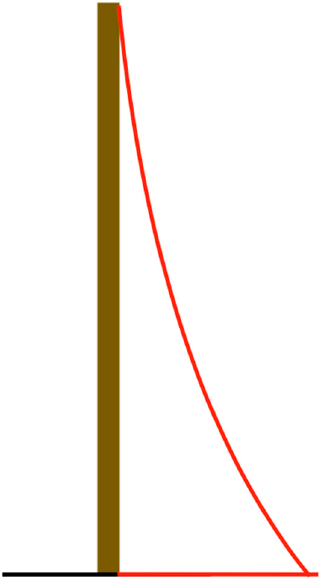
Figure A11. The 6 × 6 Bending Moment Diagram.